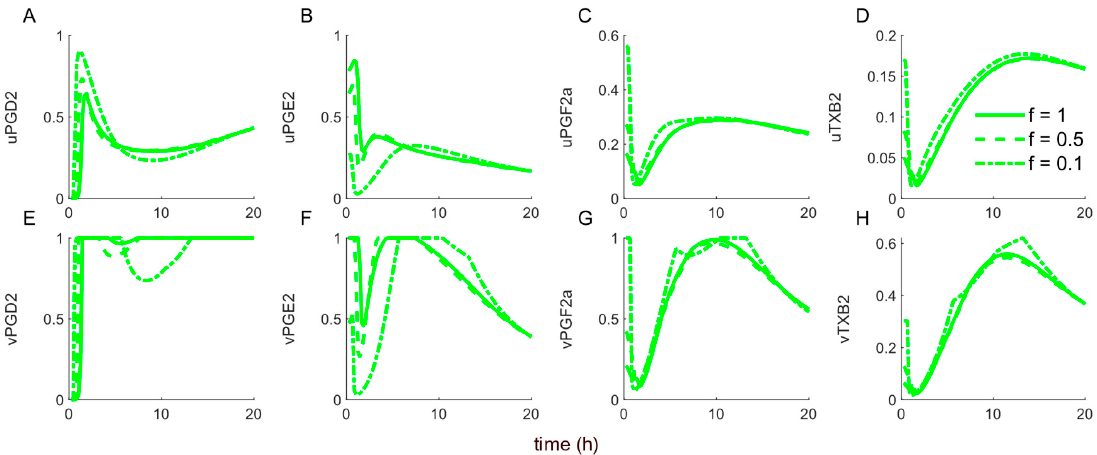
Figure 9. Gene knockdown perturbation profiles for PRs branch for cybernetic control variable u PR ( A – D ) and cybernetic control variable v PR ( E – H ). For PGE 2 , its associated cybernetic variables u -PGE 2 ( B ) and v -PGE 2 ( F ) decrease initially because of the downregulation of its flux due to de- creased scaled-enzyme Ptges (ePGE 2 ). The enzyme synthesis variables u PGD 2 ( A ), u PGF 2a ( C ), and u TxB 2 ( D ) increase because the u PR for all the PGs metabolites in the branch (PGD 2 , PGE 2 , PGF 2a , and TxB 2 ) sum to 1. The increased flux of PGD 2 , PGF 2a , and TxB 2 also results in an increase in 𝑣 PGD 2 ( E ), 𝑣 PGF 2a ( G ), and 𝑣 TxB 2 ( H ).